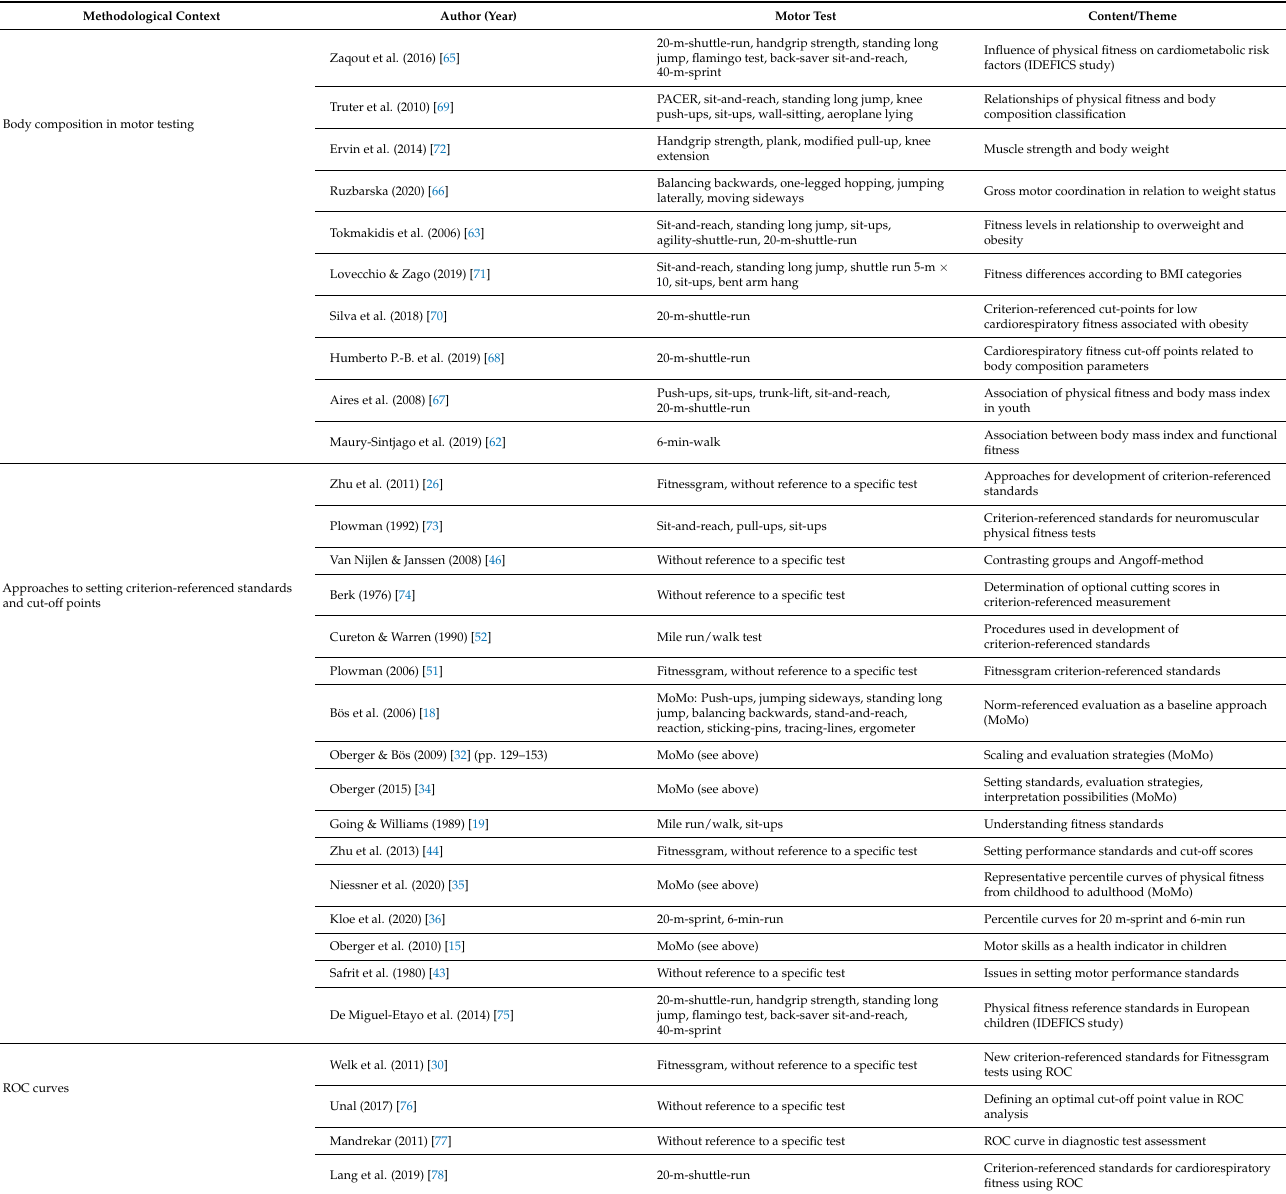
Table 2. Methodological aspects of criterion-referenced standards in health-related motor